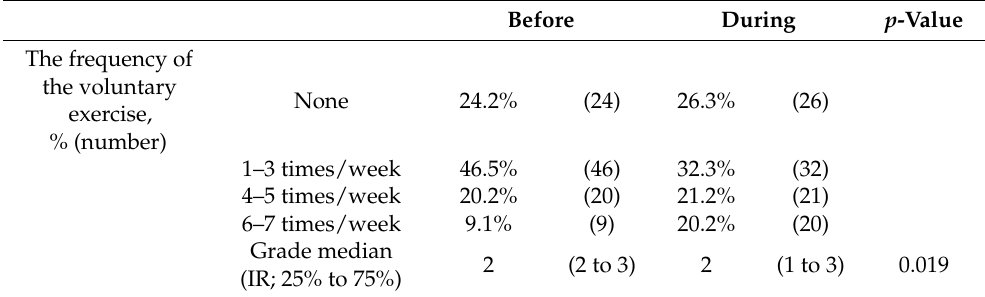
Figure 1. Frequency changes in team practice on weekdays and weekends ( n = 99). Data are shown as median values and calculated using the Wilcoxon test. ‘ × ’ demonstrate the mean value and ‘ ◦ ’ demonstrate the outlier. Abbreviations: before, before the COVID-19 pandemic; during, during the first declaration of the state of emergency; grade 1, none; grade 2, <3 h; grade 3, 3–5 h; grade 4, >5 h. Table 3. Frequency changes in voluntary exercise-related baseball on weekdays and weekends ( n = 99).